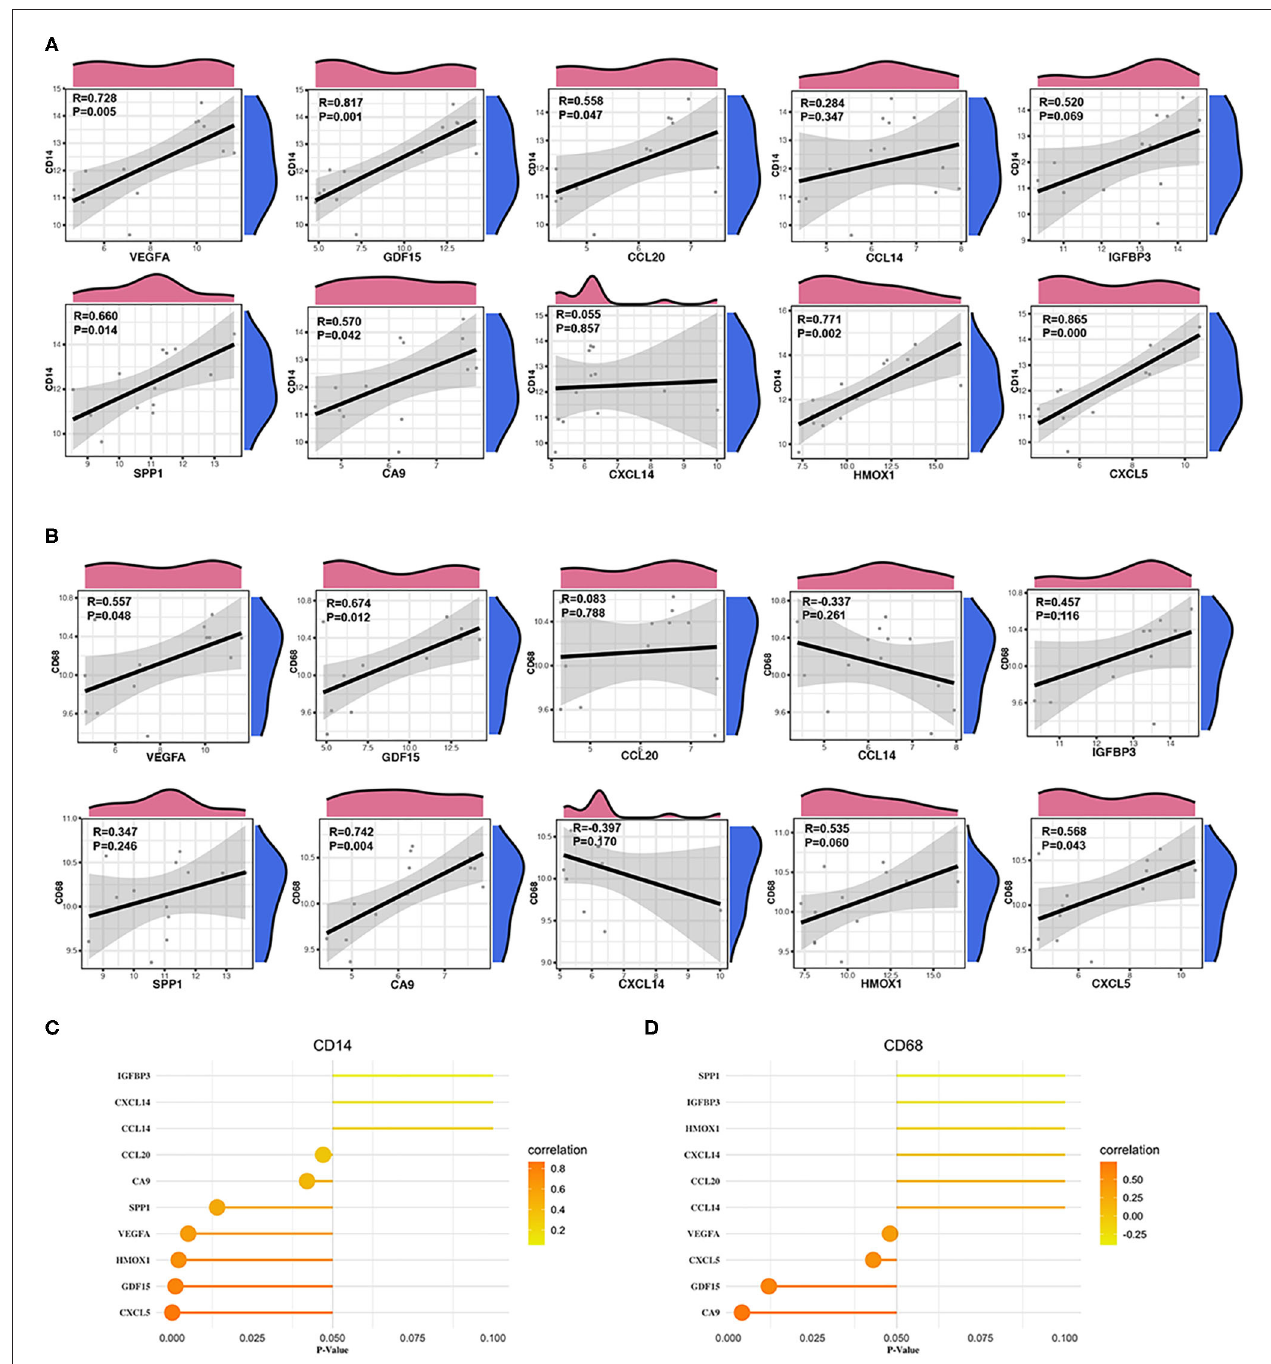
FIGURE 8 | Correlation between monocytes, macrophages and hub genes. (A) Scatter diagrams from the correlation analysis. The x axis represents the top genes, and the y axis represents CD14, which is a cell marker of monocytes. (B) Scatter diagrams from the correlation analysis. The x axis represents the top genes, and the y axis represents CD68, which is a cell marker of macrophages. (C,D) The x axis represents the P -value, and the color gradation represents the correlation coefficient. Pearson’s test was used for correlation